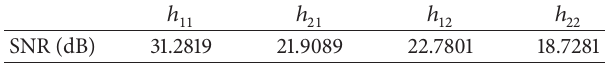
Table 2: Performance of the emulation